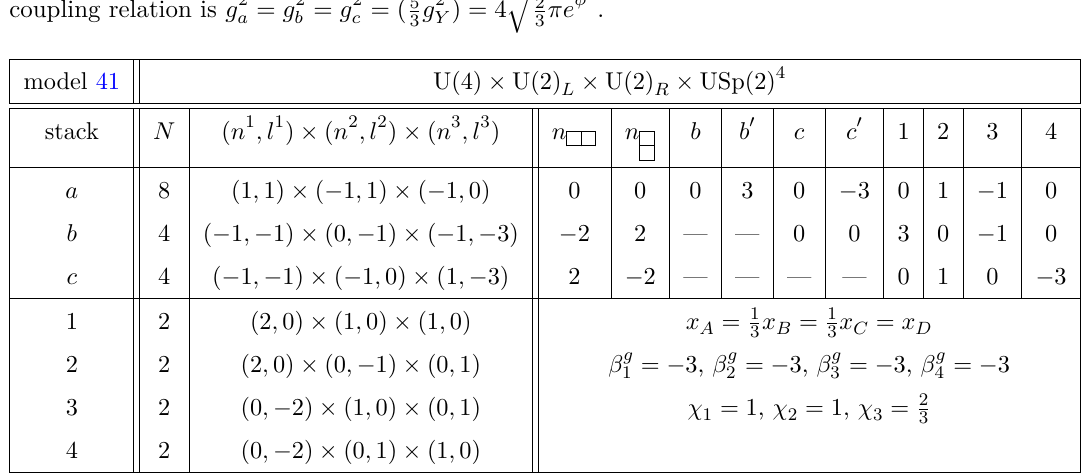
Table 40 . D6-brane configurations and intersection numbers of Model 40, and its MSSM gauge